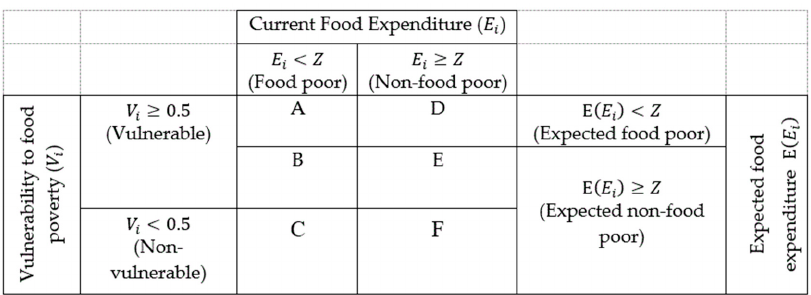
Figure 1. Categorization of food poverty and vulnerability to food poverty. Note: E i is the current food expenditure, E ( E i ) is the expected food expenditure, V i represents the vulnerability to food poverty, and Z is the least cost food poverty line.